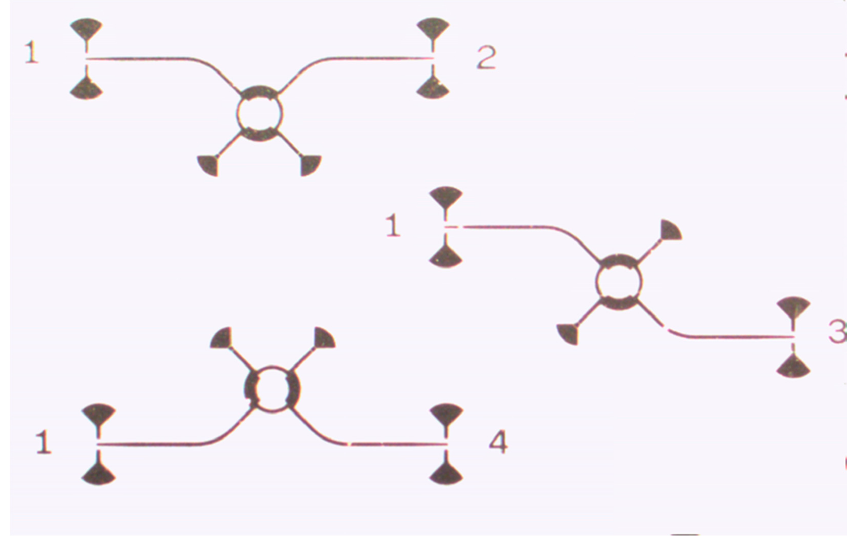
Figure 29. MHMIC 90° hybrid coupler prepared for measurements. Figure 29. MHMIC 90 ◦ hybrid coupler prepared for measurements.